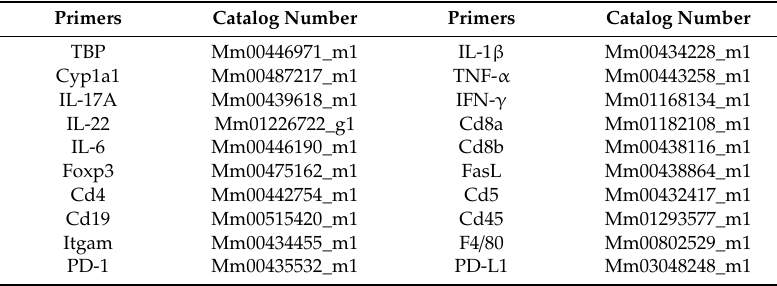
Table 1. The list of PCR primers used in this